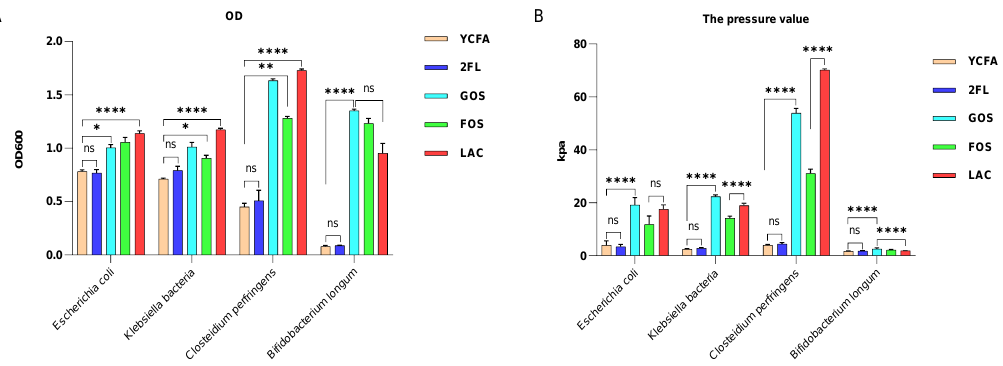
Figure 6. Effect of different carbon sources on the proliferation ( A ) and gas production of different bacteria ( B ). Both bacterial proliferation (OD value) and the pressure value were expressed as the mean ± SEM. Differences are considered significant at p < 0.05 (*), p < 0.01 (**) and p < 0.0001 (****). Further analysis of the production of each type of gas in the aforementioned monobac- terial fermentation media showed that only E. coli , K. pneumonia , and C. perfringens , not Bifidobacterium , produced CO 2 , H 2 , and H 2 S (Figure 7).